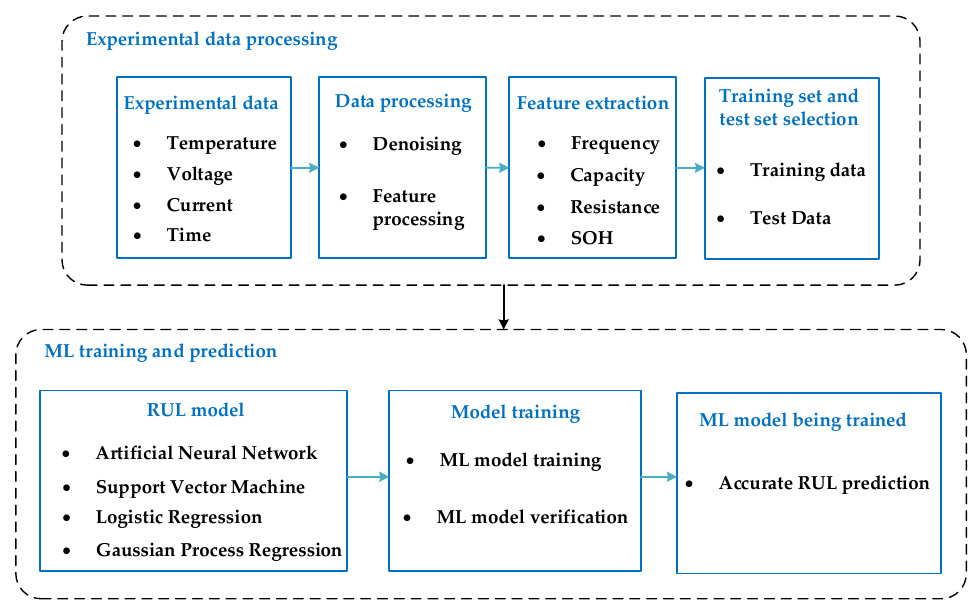
Figure 1. The basic workflow of applying ML to RUL prediction.